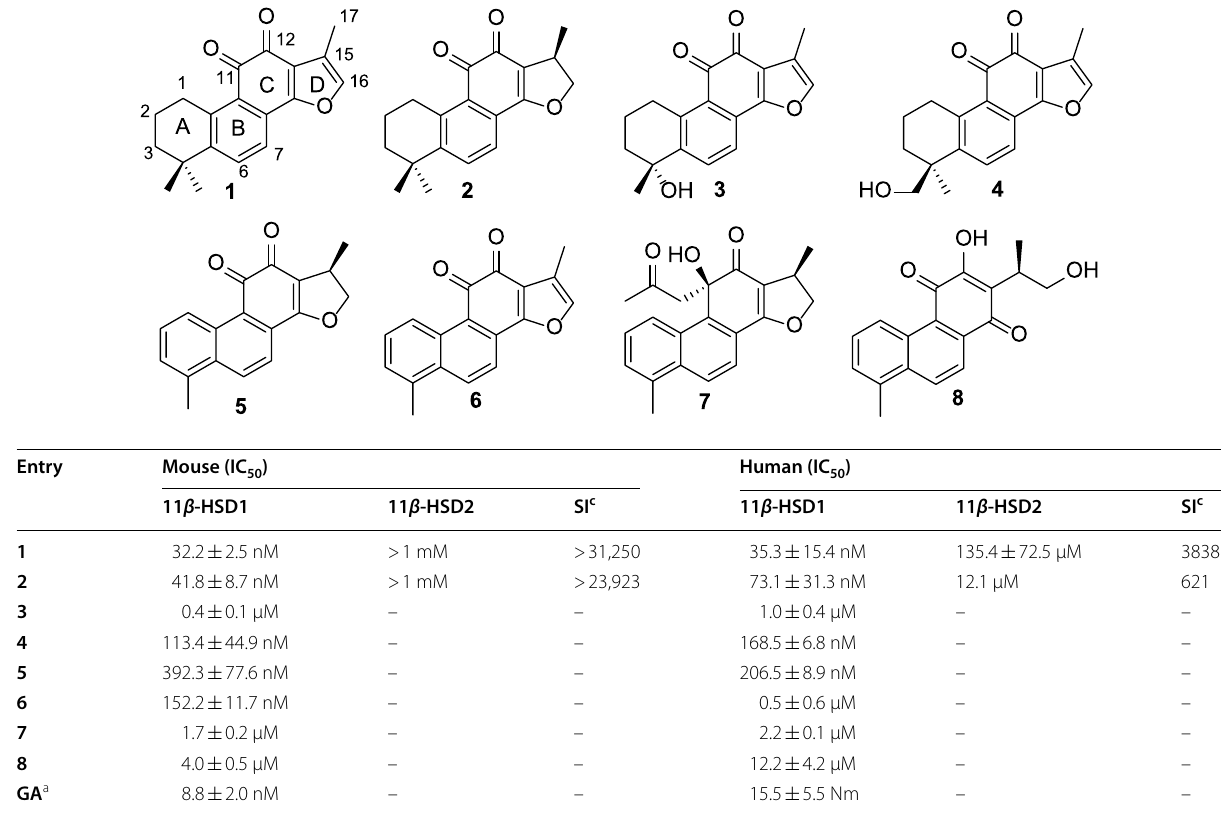
Table 1 Initial enzymatic assay of tanshinones from Salvia trijuga